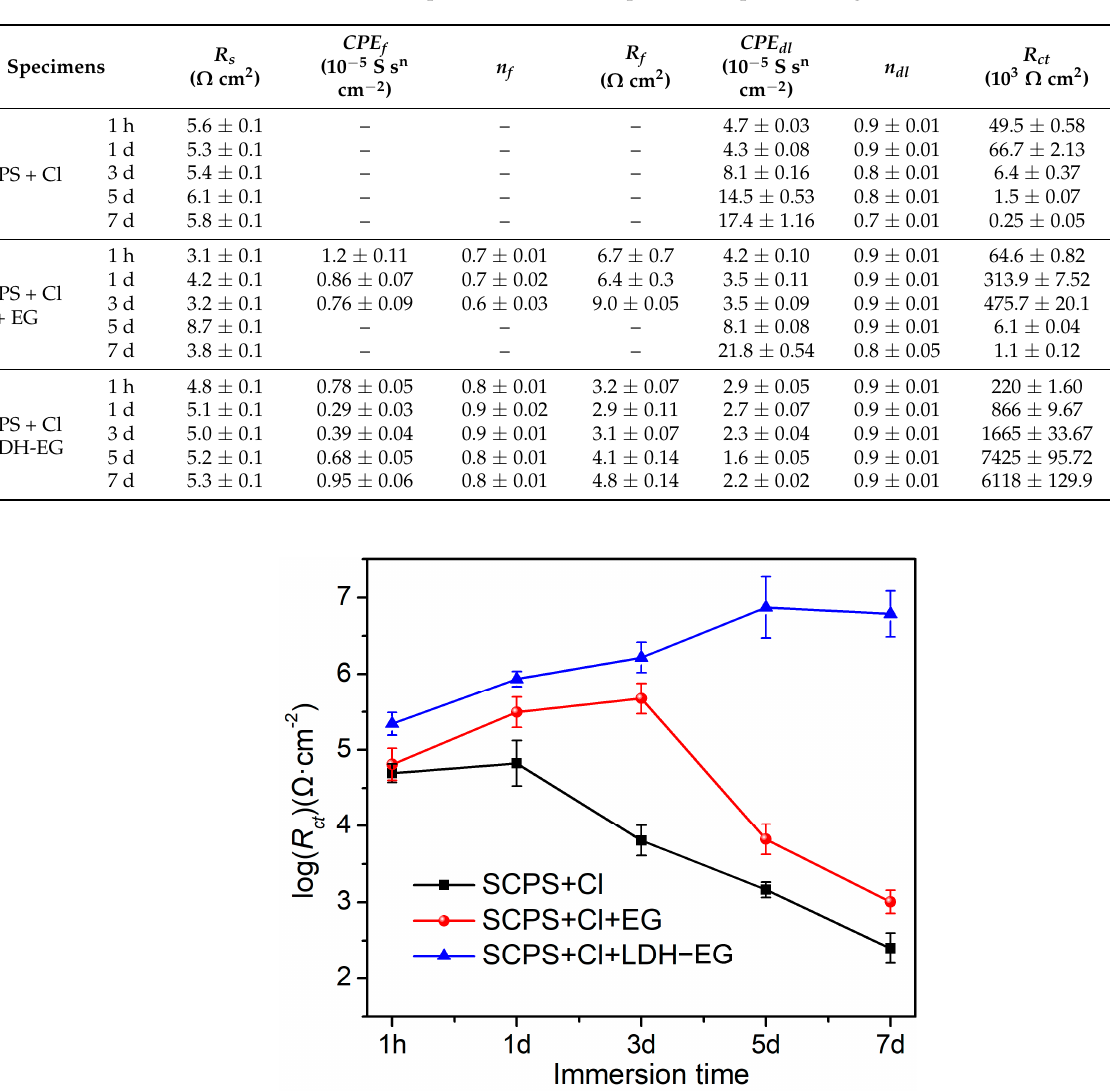
Table 1. Fitted parameters for EIS spectrum depicted in Figure 6.